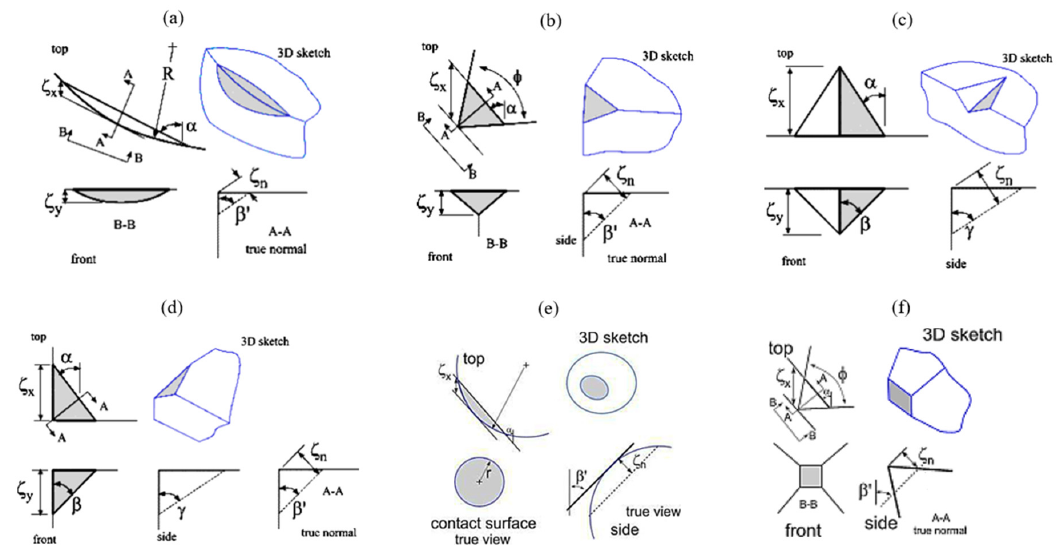
Figure 1. Considered contact geometry models: ( a ) Round; ( b ) Angular; ( c ) Symmetric v wedge; ( d ) Right-apex oblique; ( e ) Spherical; ( f ) Pyramid (Adapted with permission from Daley [34], The American Society of Mechanical Engineers,